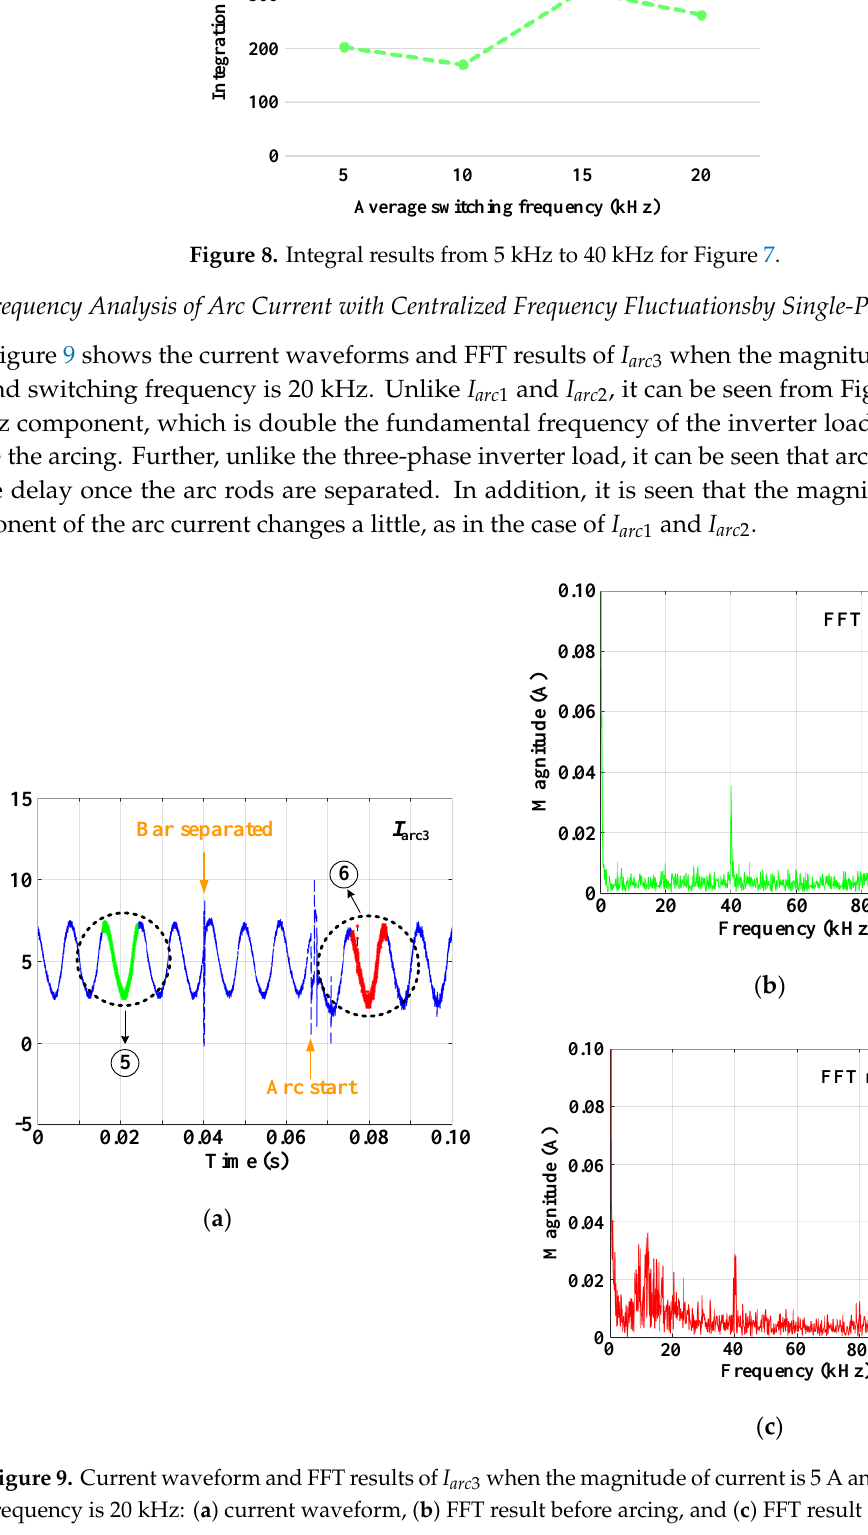
Figure 7. FFT differences after and before arc generation based on the current magnitude and average